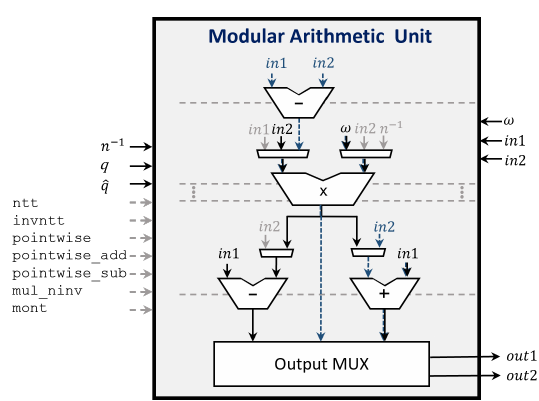
Figure 6: Modular Arithmetic Unit. Black: decimation in time, blue dashed: decimation in frequency, gray: pipeline stages and other functionalities.